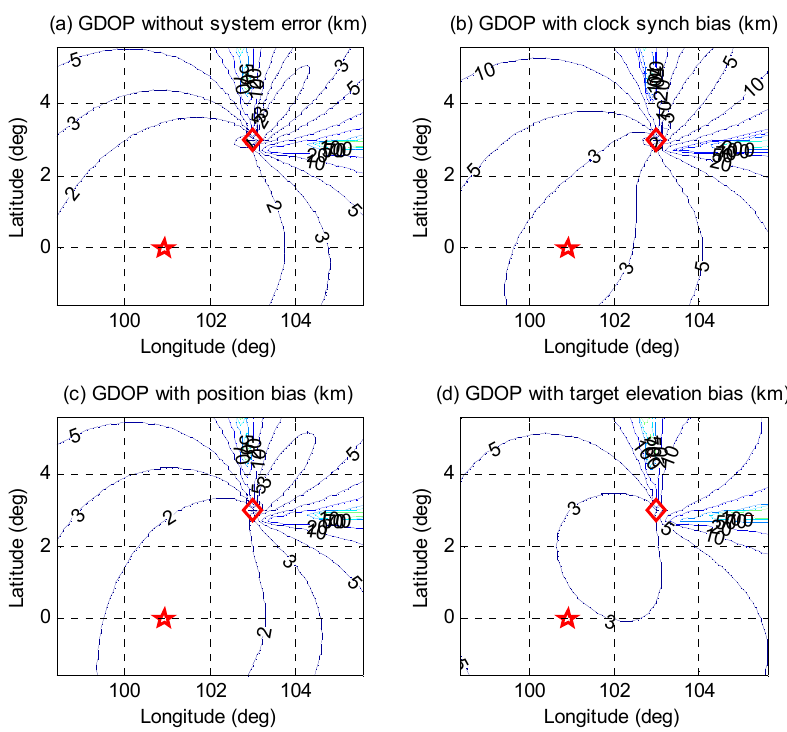
Figure 4. GDOPs of position estimation using the LEO and airplane.